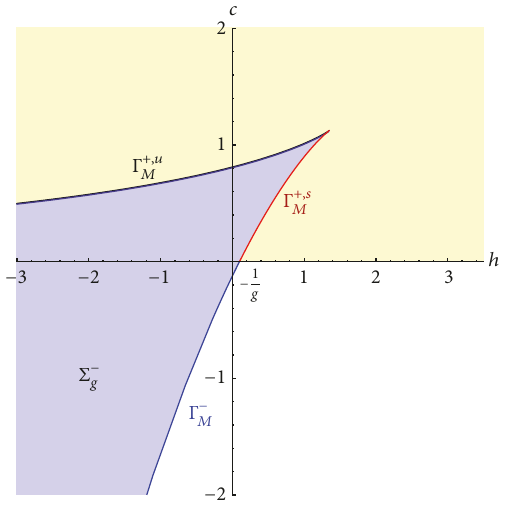
Figure 2: The image of the energy-Casimir mapping ( 𝑔 = −10, 𝑎 = 2, 𝑏 = 1 ).